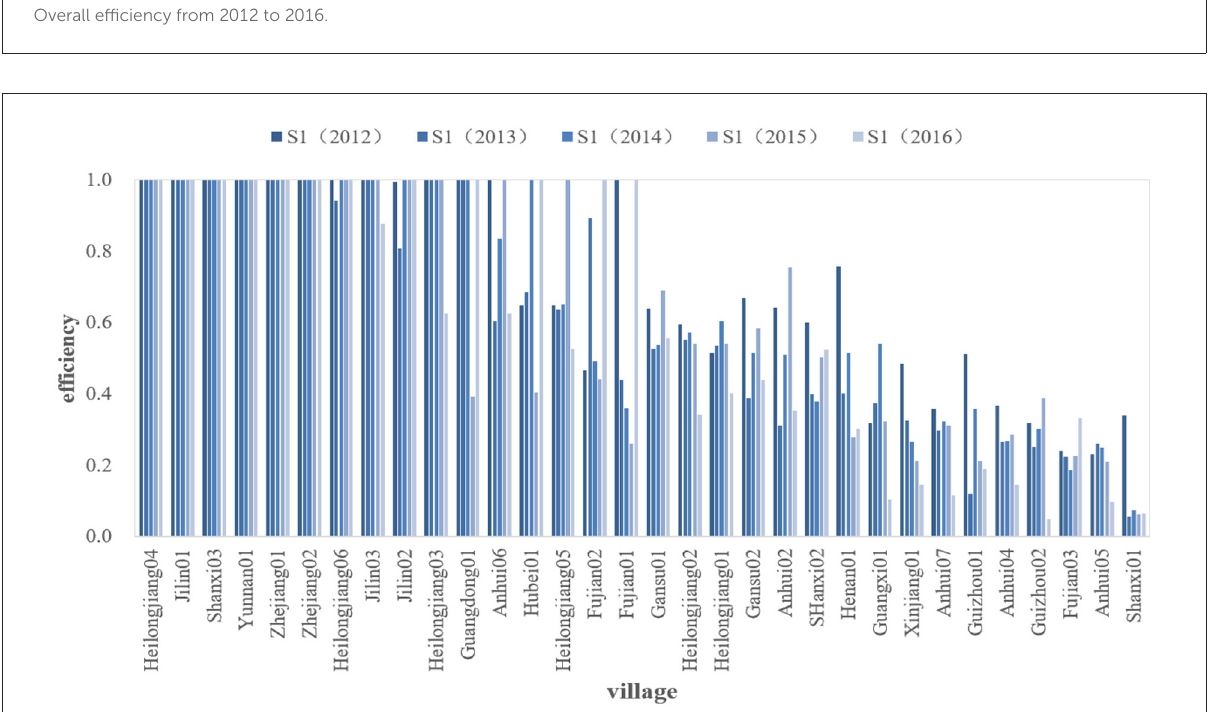
FIGURE4 Agricultural production efficiency at the first stage, from 2012 to